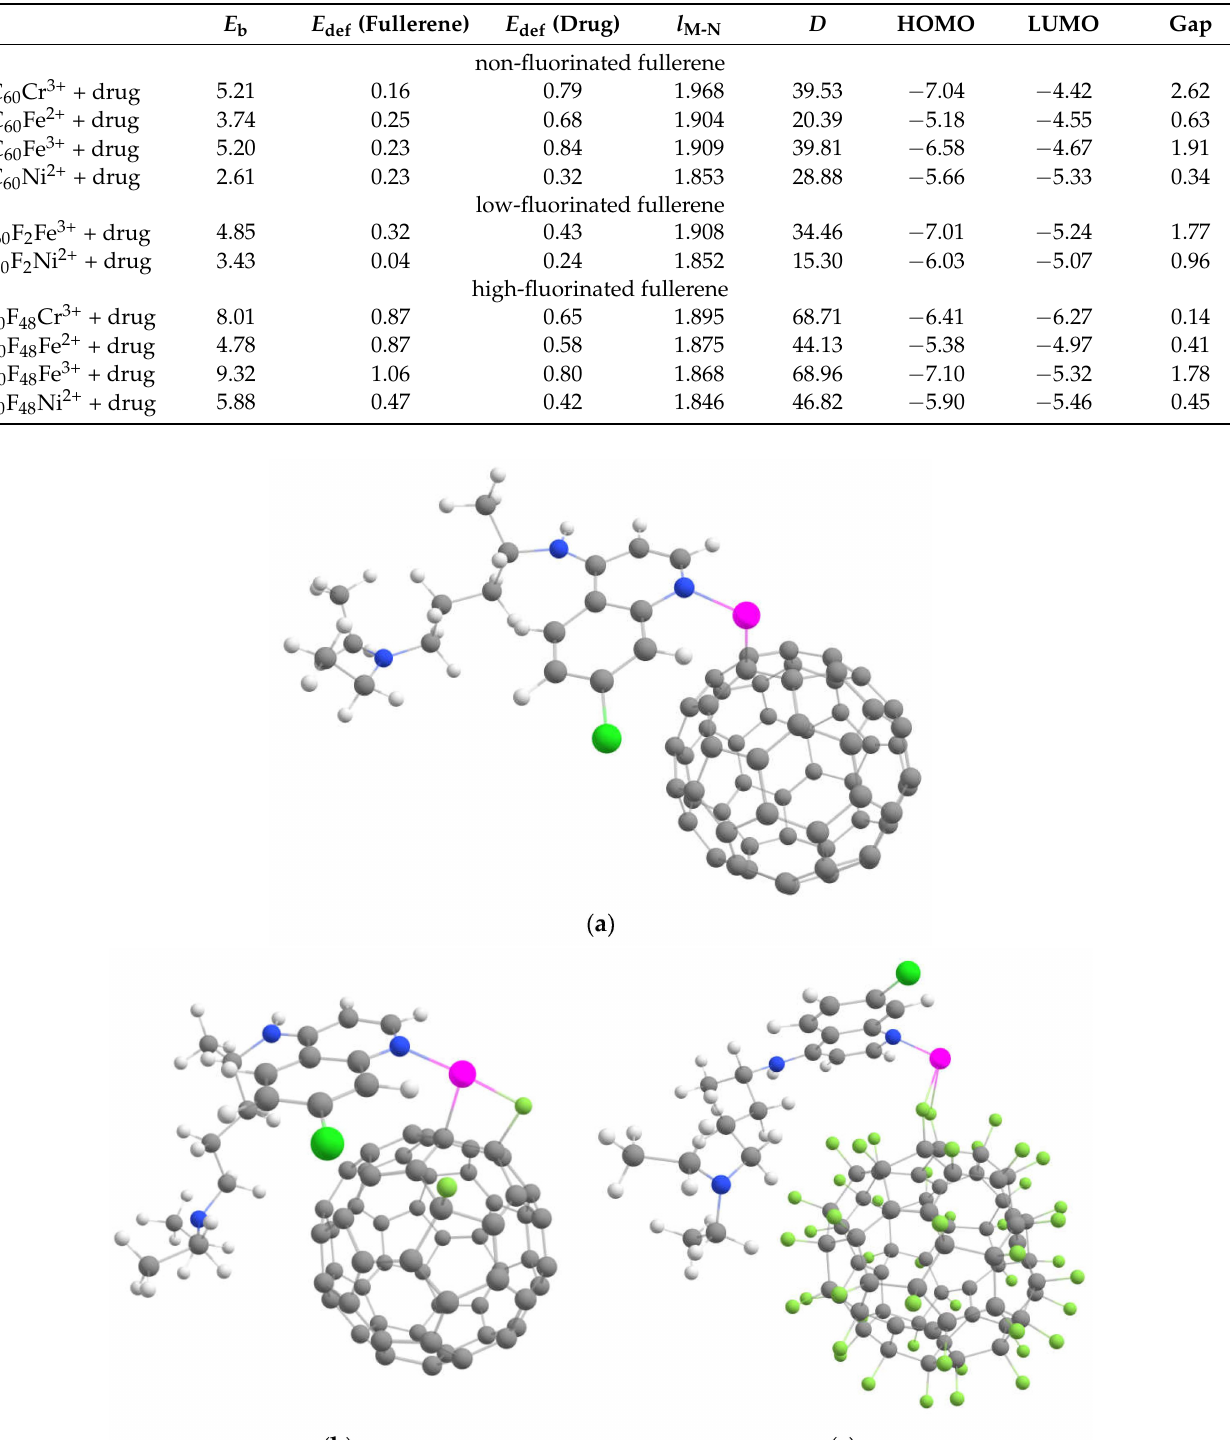
Table 3. Calculated geometric and energetic characteristics of metal-decorated pristine and fluori-